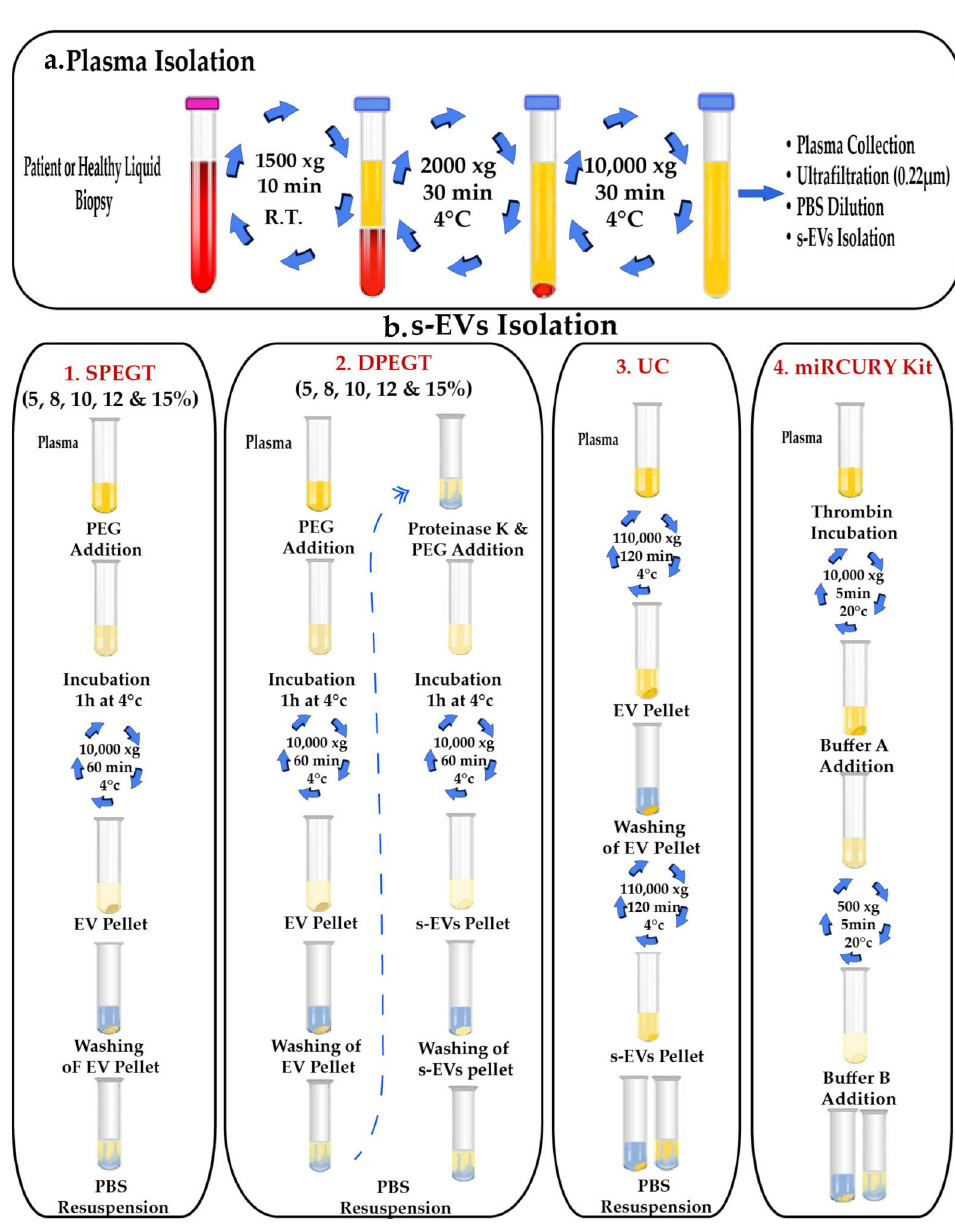
Fig 1. Schematic illustration of isolation procedures for sEVs. (a) Blood processing and plasma isolation. (b) Detailed steps of sEVs isolation using single PEG6000 treatment (SPEGT), double PEG6000 treatment (DPEGT), ultracentrifugation (UC) and miRCURY kit. The PEG incubation period could optionally range from 1 to 24